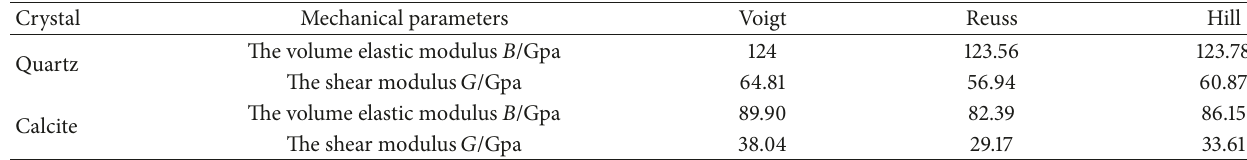
Table 7: Bulk modulus and shear modulus of the two mineral